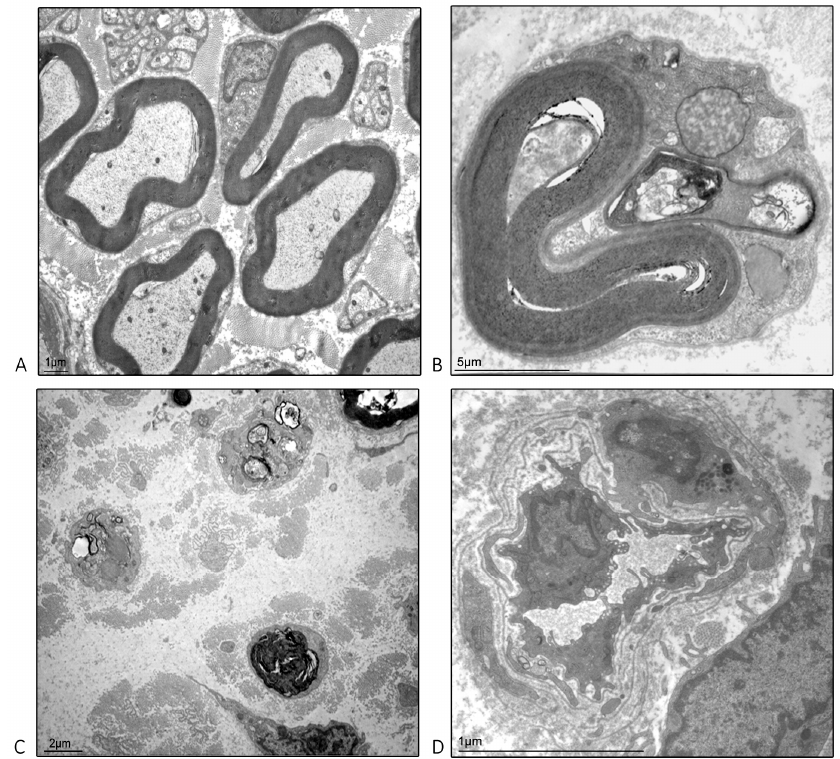
Figure 6. Representative images of length-dependent damage observed in the peripheral neuropathy (PN) group. ( A ): images at the base of the tail. ( B ): images at the mid of the tail. ( C ): images at the tip of the tail. ( D ): a monocyte leaving the vascular compartments to become a tissue macrophage in one of the distal portions.